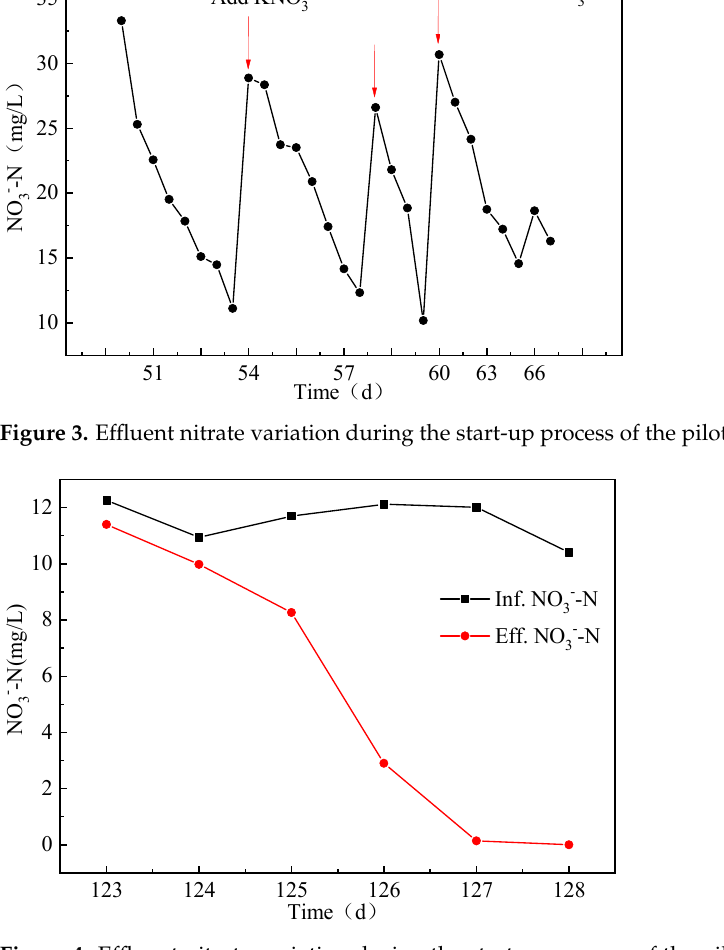
Figure 4. Effluent nitrate variation during the start-up process of the pilot-scale bioreactor by the low-flow effluent strategy.